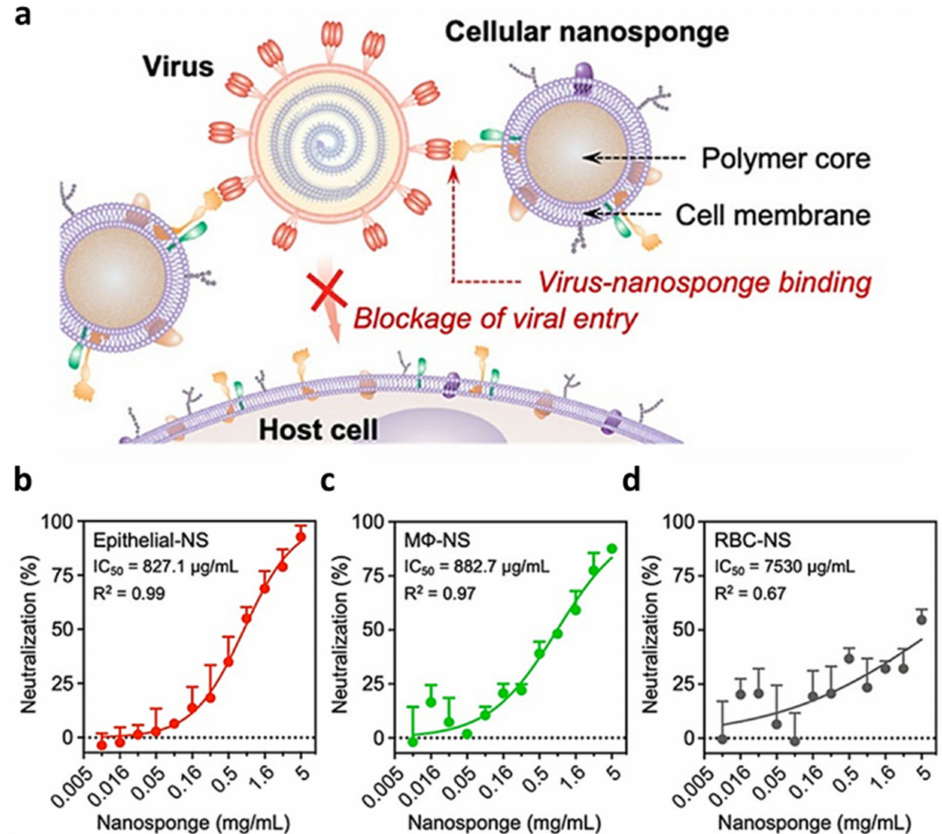
Figure 6. ( a ) Schematic representation of cellular nanosponges inhibiting SARS-CoV-2 infectivity. The nanosponges are formulated by wrapping polymeric nanoparticles with cell membranes from target cells such as lung epithelial cells and macrophages (M Φ s). The resulting nanosponges (denoted “Epithelial-NS” and “M Φ -NS”, respectively) inherit the surface antigens of the source cells and serve as decoys to bind with SARS-CoV-2. To block viral entry and inhibit viral infectivity. ( b ) Epithelial-NS, ( c ) M Φ -NPs, and ( d ) nanosponges made from red blood cell membranes (control) was tested using live SARS-CoV-2 viruses on Vero E6 cells. In all data sets, n = 3. Data are presented as mean + standard deviation. Horizontal dashed lines mark the zero levels. Figure adapted with permission from Nano Lett. 2020 , 20 , 5570–5574 (https://pubs.acs.org/doi/10.1021/acs.nanolett.0c02278). Copyright 2019 American Chemical Society (accessed on 1 March